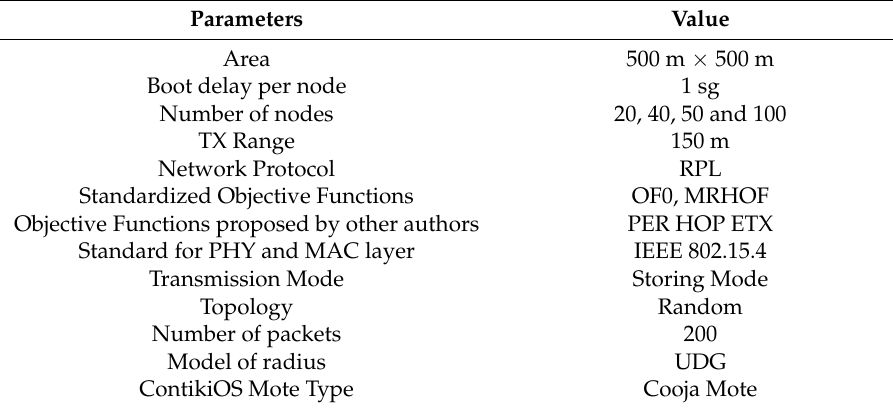
Table 2. Summary of simulation parameters.